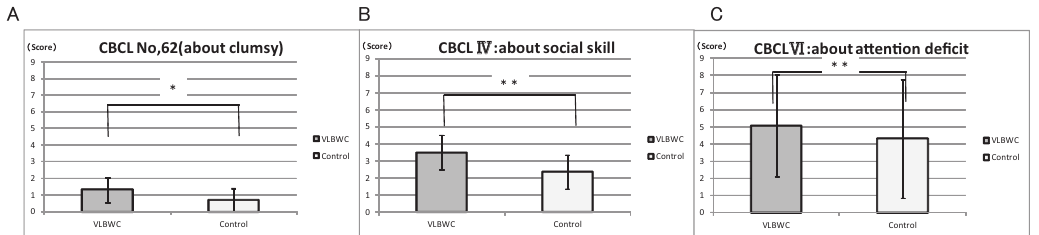
Figure 3. Comparison of the child behavior checklist (CBCL) between 6-year-old very low birth weight children (VLBWC) and the controls. ( A ) Checklist no. 62 on the CBCL. ( B ) Social skill index (IV) on the CBCL. ( C ) Attention deficit in- dex (VI) on the CBCL. *indicates > 0.05, **indicates >